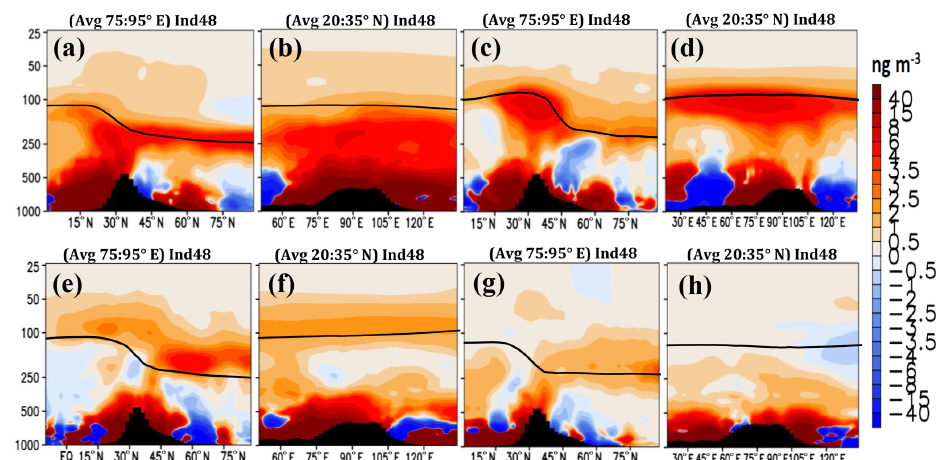
Figure 4. Vertical cross section of anomalies in sulfate aerosols (ngm − 3 ) from Ind48-CTRL simulations for the pre-monsoon season (a) latitude–pressure section and (b) longitude–pressure section; (c) – (d) same as (a) – (b) but for the summer-monsoon season; (e) – (f) same as (a) – (b) but for the post-monsoon season; (g) – (h) same as (a) – (b) but for the winter season. The averages obtained over latitudes or longitudes are indicated in each panel. The black vertical bars indicate topography, and a black line indicates the tropopause.